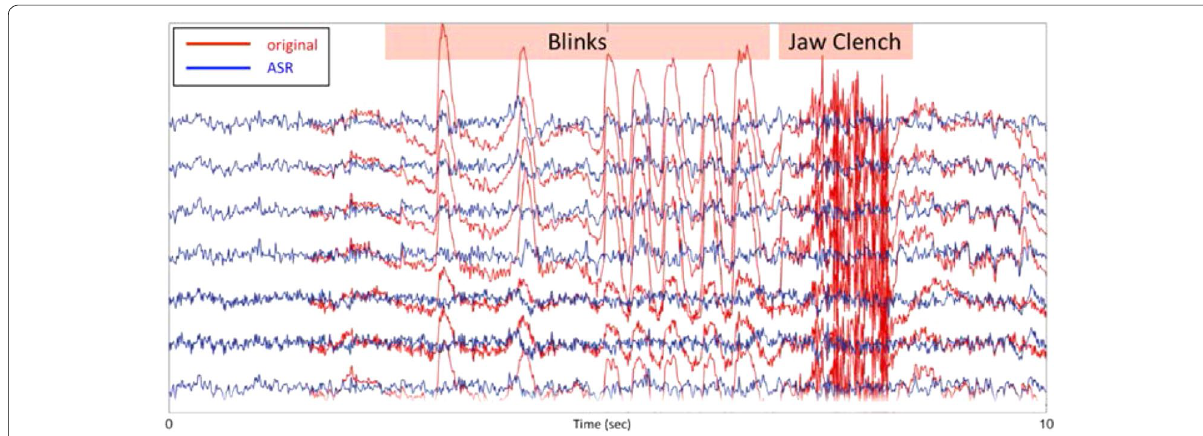
Fig. 5 Example of filtering out movements from EEG using ASR [58]